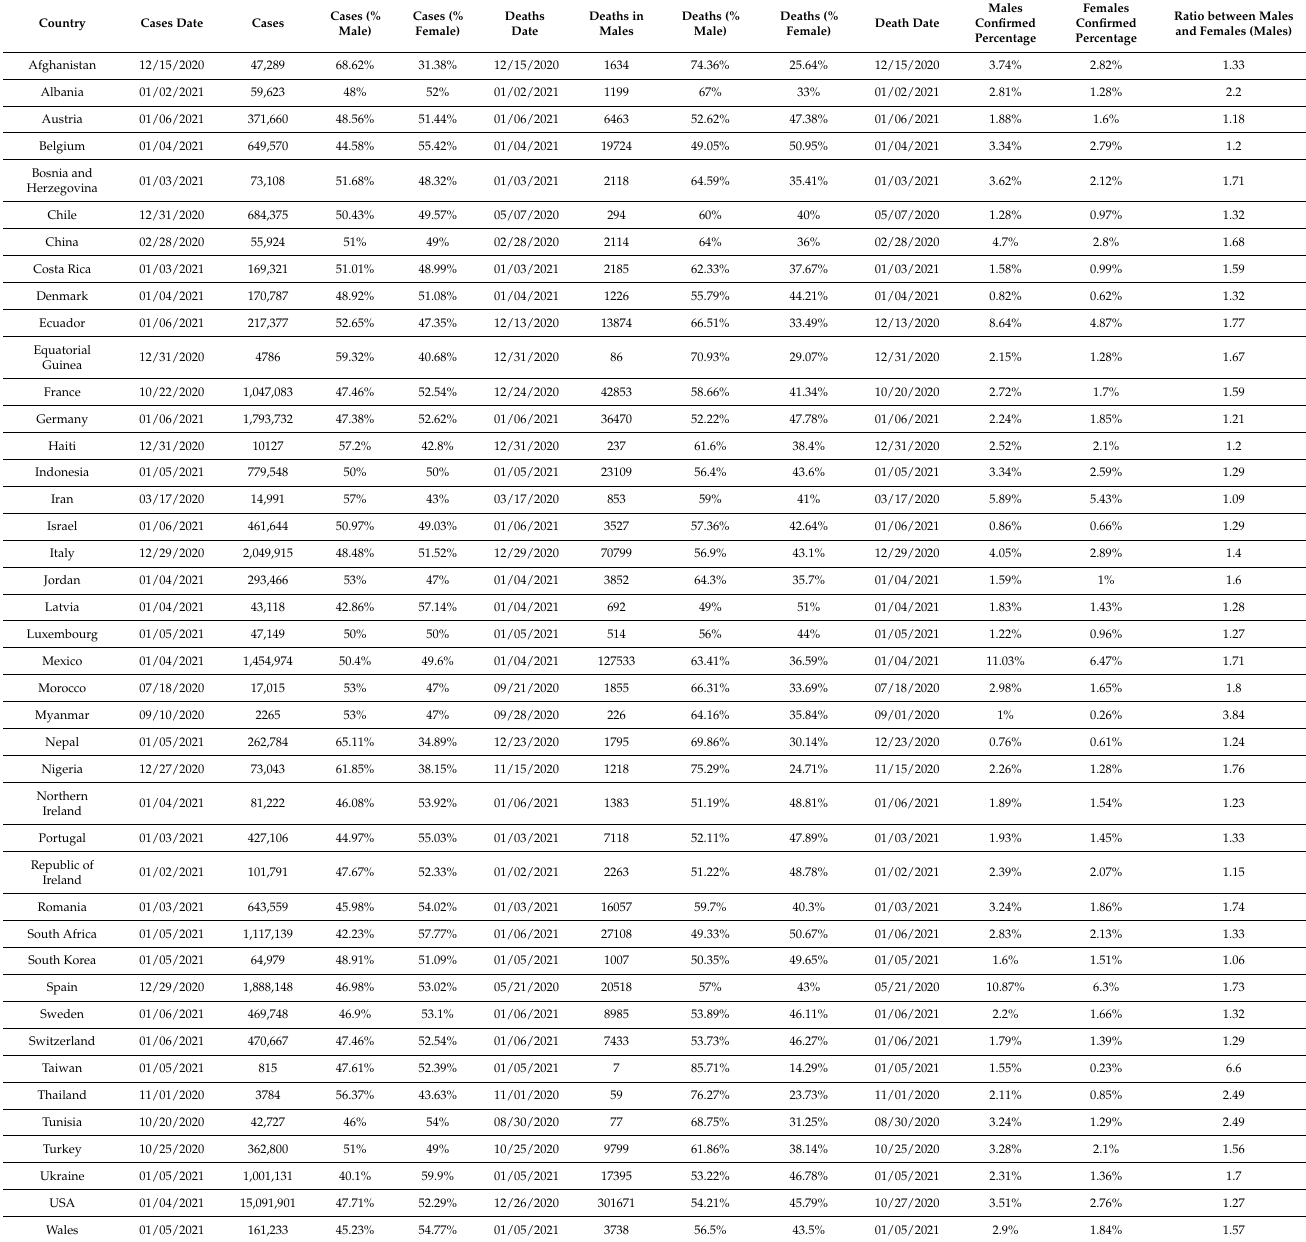
Table A1. Distribution of gender, ages, and death rate among various countries. Note that these data were aggregated from online health